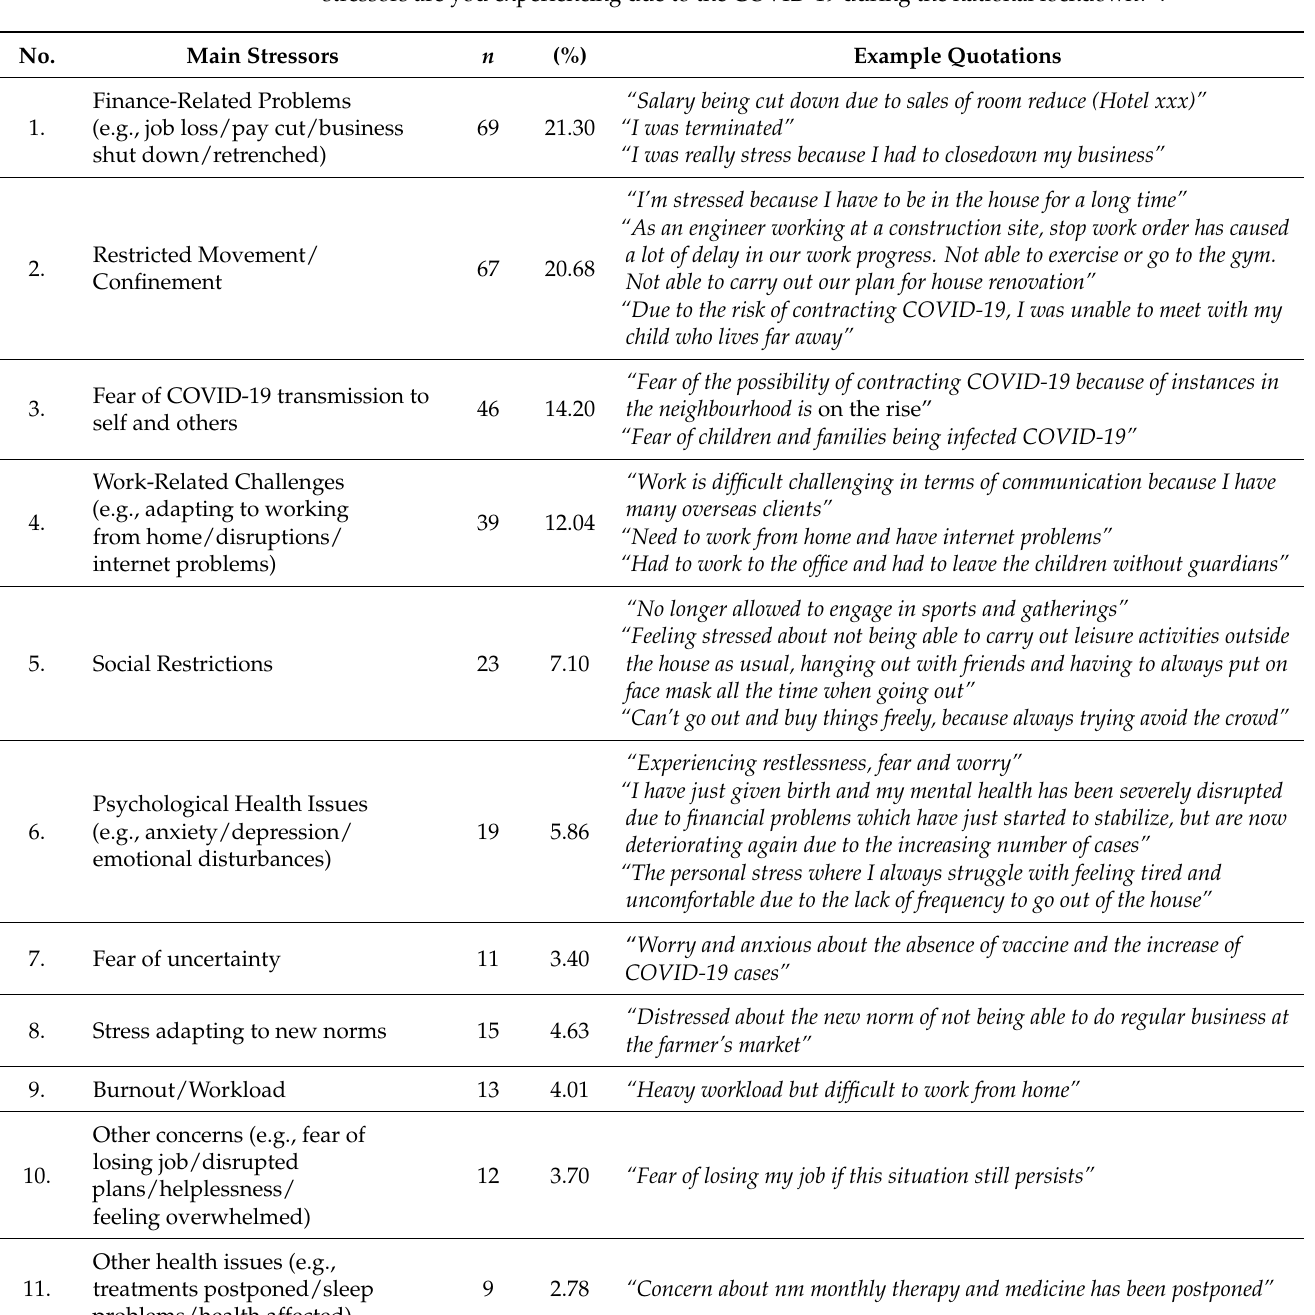
Table 2. Reported main stressors encountered during the lockdown due to COVID-19, “What stressors are you experiencing due to the COVID-19 during the national